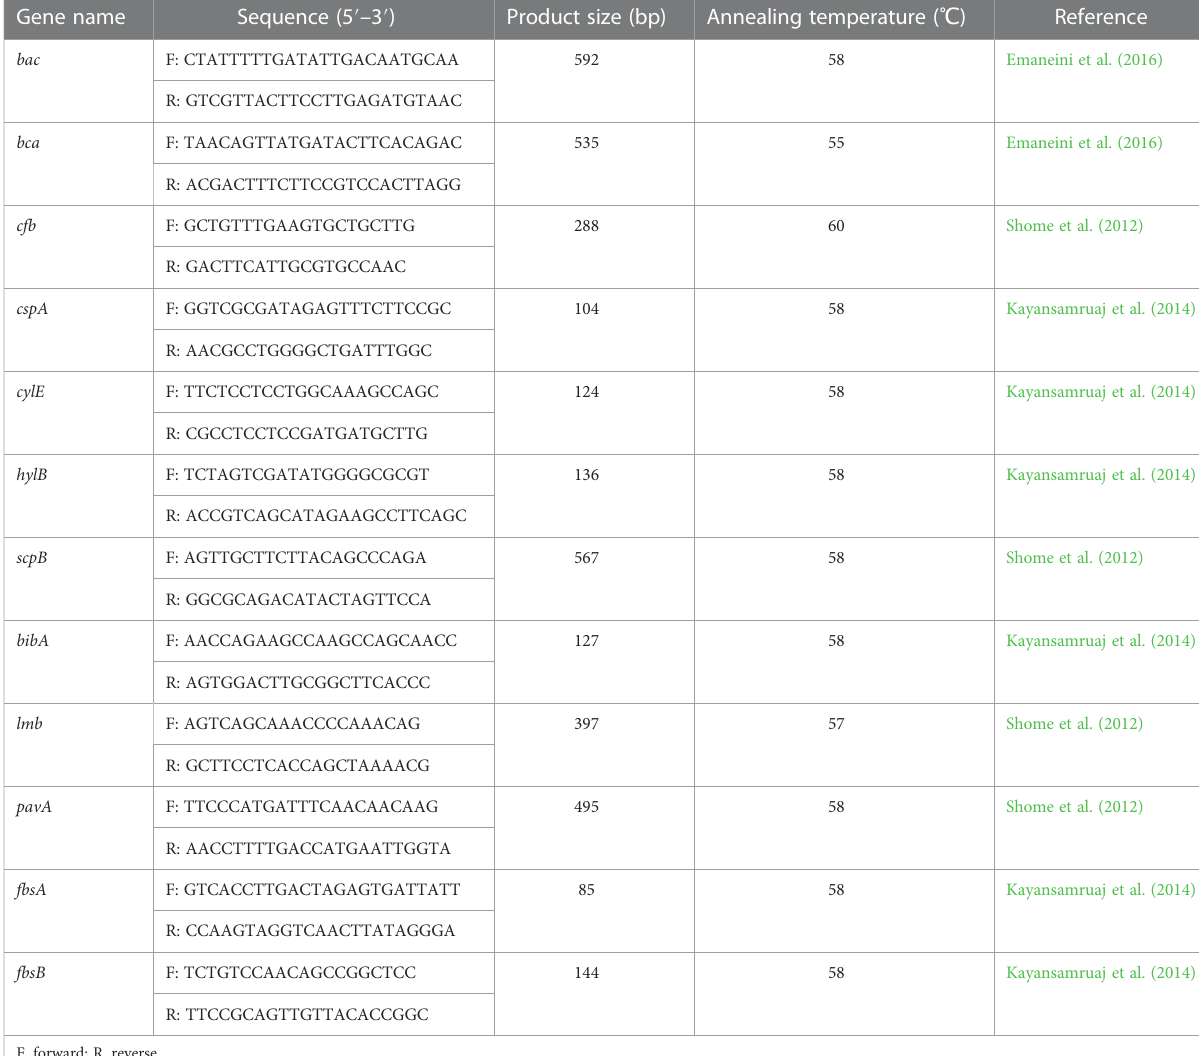
TABLE 3 Primers of virulence